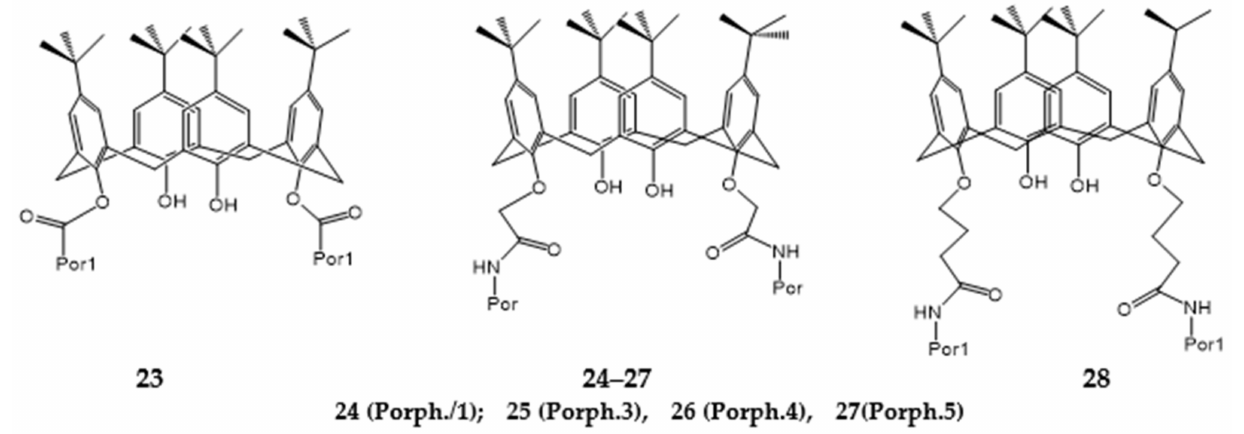
Figure 4. Structures of the Bis-porphyrins 23 – 28 .